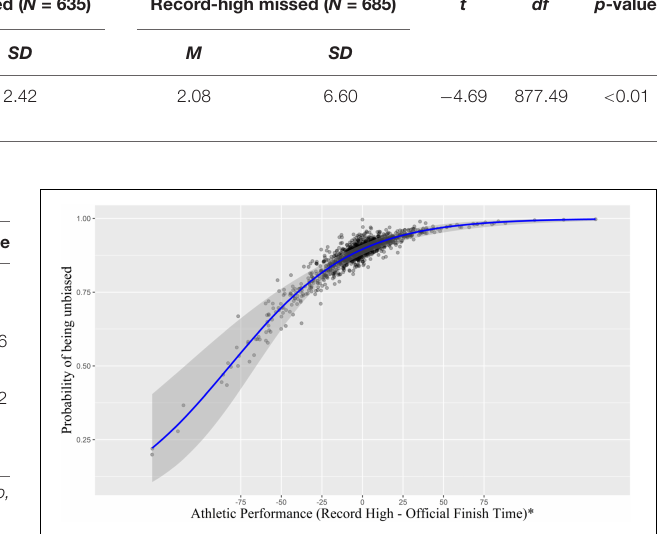
FIGURE 2 | Probability of being unbiased based on the level of athletic performance. *A positive number of athletic performance indicates that a runner broke her/his record-high at the event. The solid blue line shows predicted effects of Athletic Performance, the gray area shows 95% CI, and the black dots represent the actual data